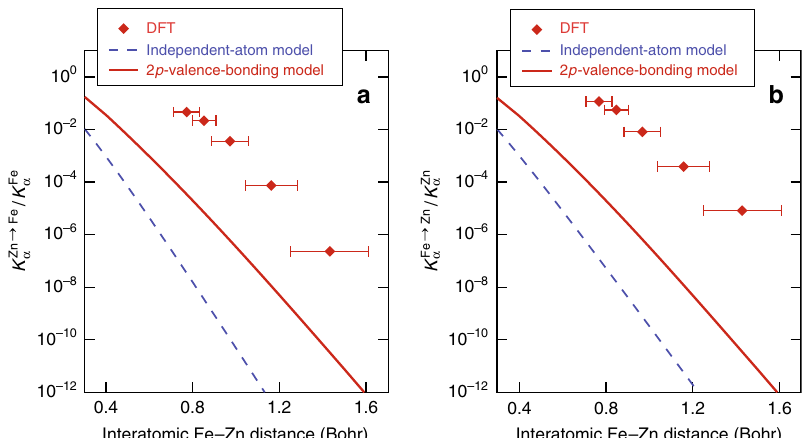
Fig. 5 Model predictions of IRT in comparison with DFT calculations. a The ratio of inter-atomic K α emission (from Zn to Fe) to the regular intra-atomic K α signal (within Fe) as a function of inter-atomic Fe – Zn distance. b Similar to a but for inter-atomic K α emission from Fe to Zn. All of these calculations were done at different plasma densities with the same temperature of kT = 50 eV. DFT stands for density-functional theory. The “ error bar ” in DFT data represents the full-width half-maximum of